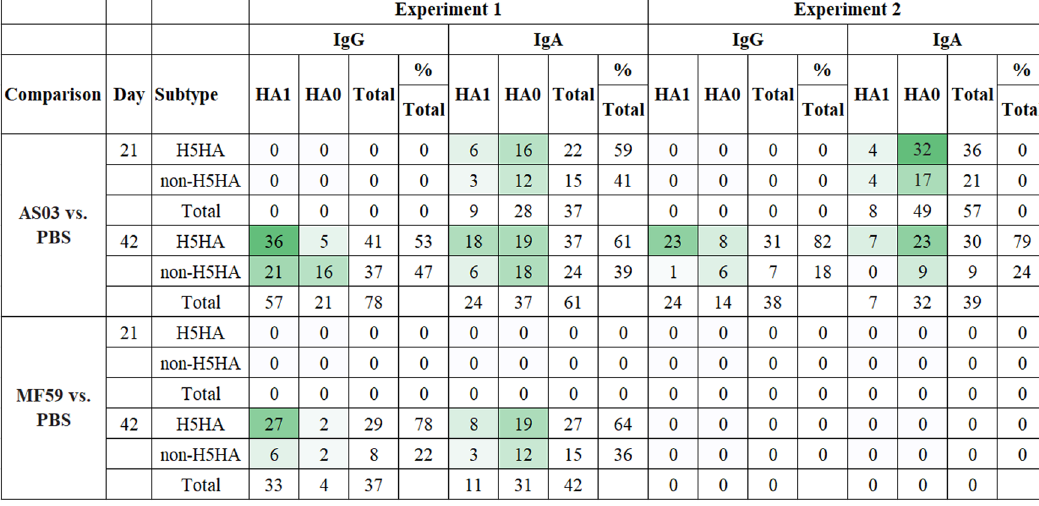
Fig. 4 Summary of statistically signi fi cant adjuvant-boosted antibody responses. For each antigen, an ANOVA model was fi tted to day 21 and day 42 log 2 fold change responses to assess the statistical signi fi cance of contrasts that compared adjuvanted vs. control group responses (AS03 – PBS and MF59 – PBS) adjusting for prior seasonal in fl uenza vaccination using an FDR-adjusted p value